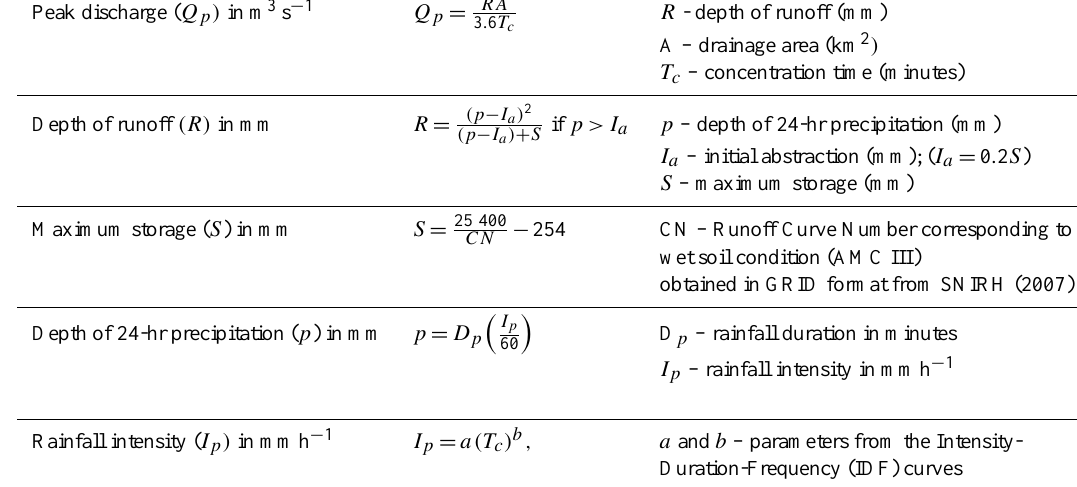
Rainfall intensity ( I p ) in mmh − 1 I p = a ( T c ) b ,